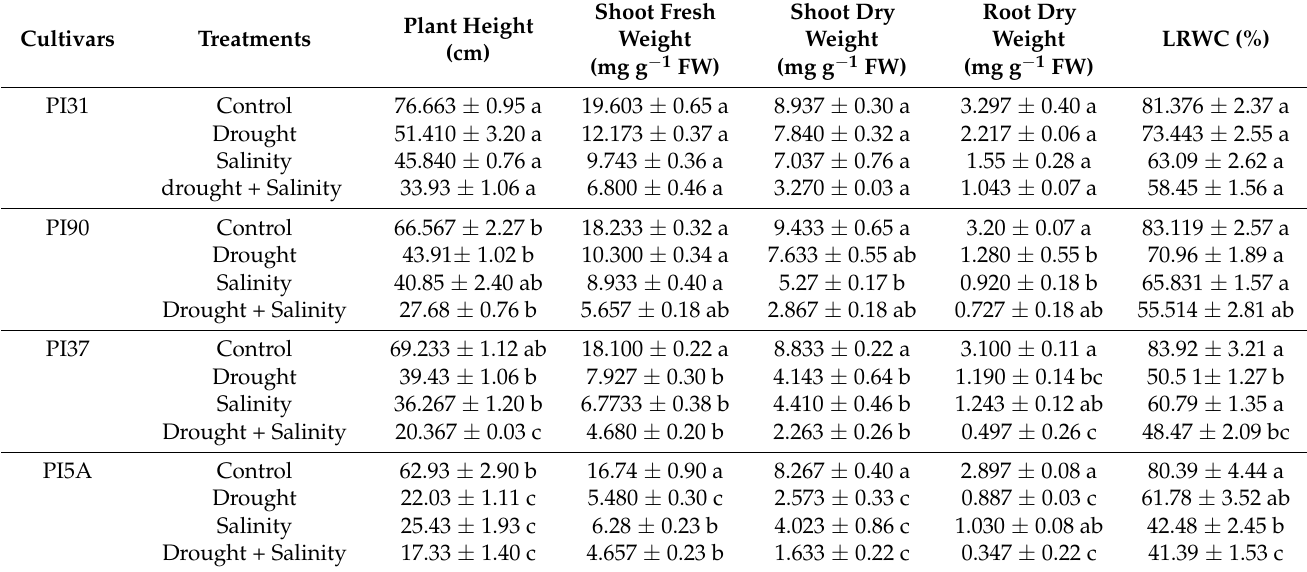
Table 2. Plant height, shoot fresh weight, shoot dry weight, root dry weight, and leaf relative water content (LRWC) of four soybean cultivars grown under drought and salinity stress conditions. Data presented are means ± SD. Different letters denote a significant difference at p < 0.05 based on the least significant difference (LSD)